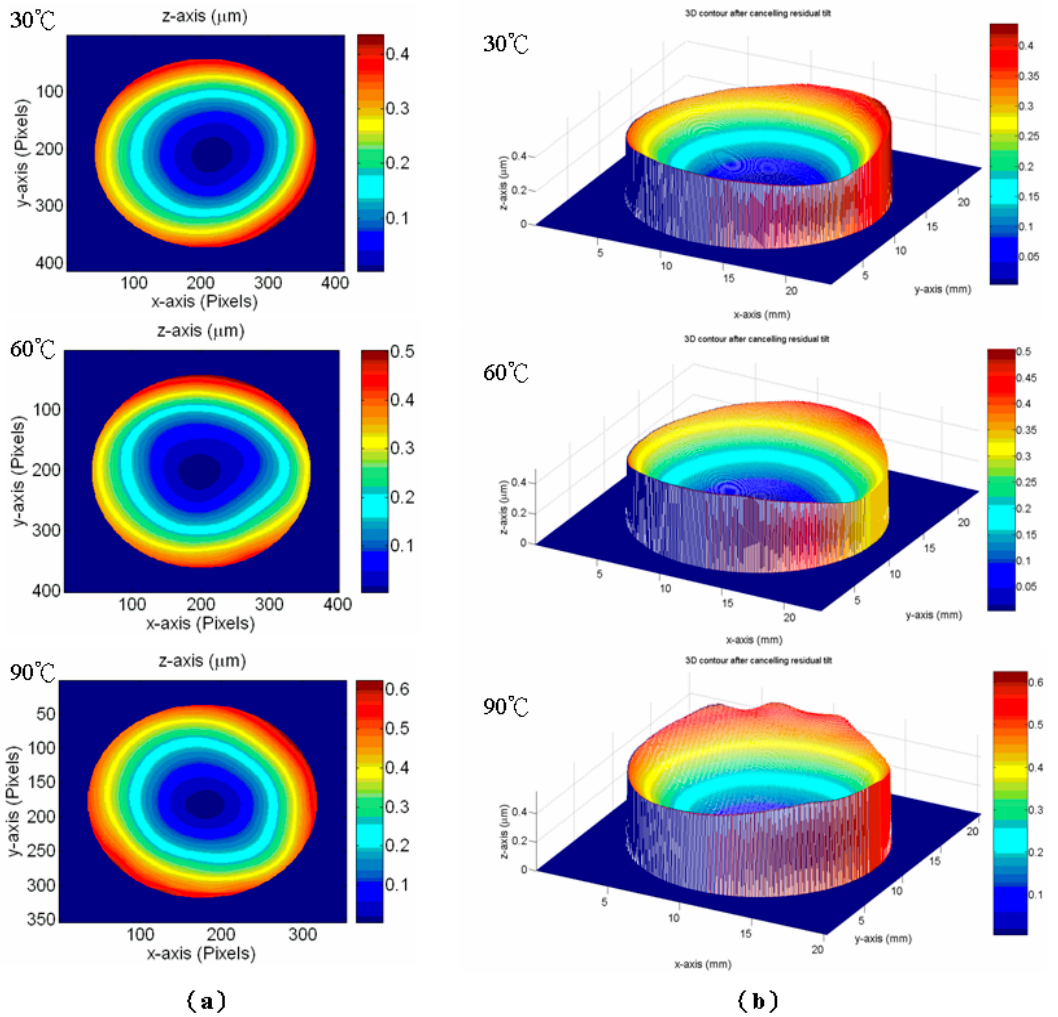
Figure 5. Surface profile changes of the ITO film deposited on the N-BK7 glass substrate in the heating temperature range of 30–90 °C. ( a ) Two-dimensional profile. ( b ) Three-dimensional surface topography.